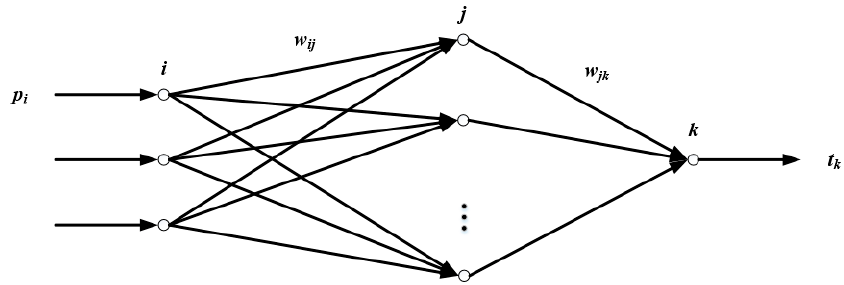
Figure 6. Simplified back propagation (BP) neural network diagram.